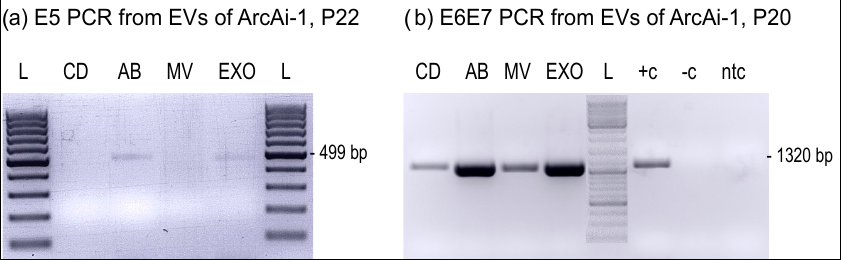
Figure 7. EVs, notably ABs and EXOs, harbor BPV1 DNA. BPV1 E5 ( a ) and E6E7 PCR from EV species isolated from cell-free culture supernatant of ArcAi-1 in P20 ( b ) and P22 ( a ). L: GeneRuler 100 bp DNA Ladder (Thermo Fisher Scientific); CD: cell debris; AB: apoptotic bodies; MV: microvesicles; EXO: exosomes; +c: positive control (sarcoid DNA); -c: negative control (normal equine skin DNA); ntc: no-template control (sterile water).